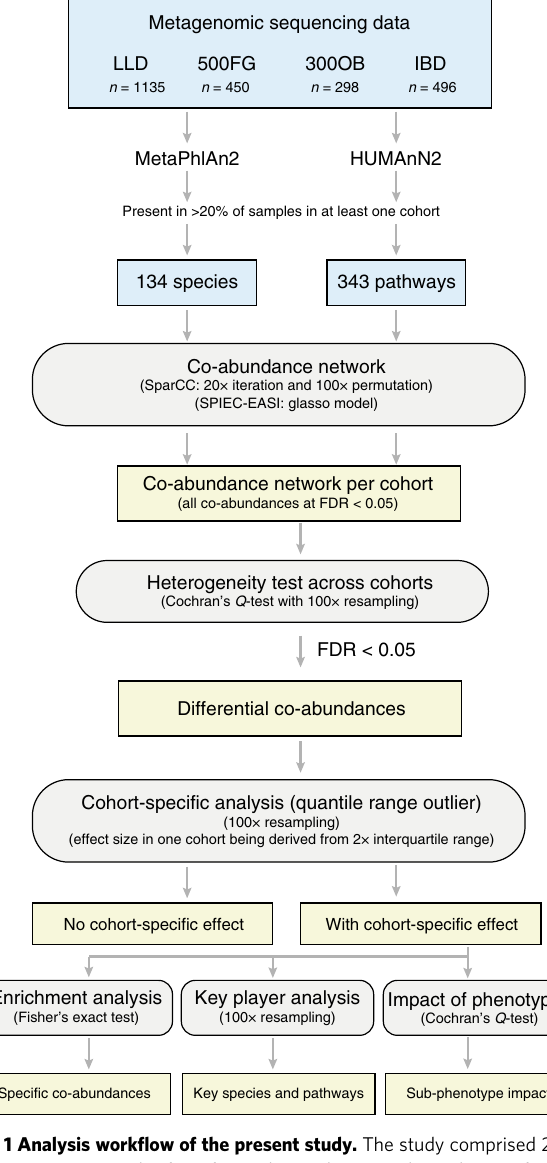
Fig. 1 Analysis work fl ow of the present study. The study comprised 2,379 metagenomics samples from four cohorts: the general population LifeLines- DEEP cohort (LLD), the 500FG cohort, an obesity cohort (300OB), and an in fl ammatory bowel disease (IBD) cohort. By combining SparCC and SPIEC- EASI methods, we constructed species and pathway co-abundance networks in each cohort separately. The established co-abundances were then subjected to heterogeneity testing and cohort-speci fi city analysis to assess whether the effect size of each co-abundance was signi fi cantly different between cohorts and whether the differences were driven by a speci fi c